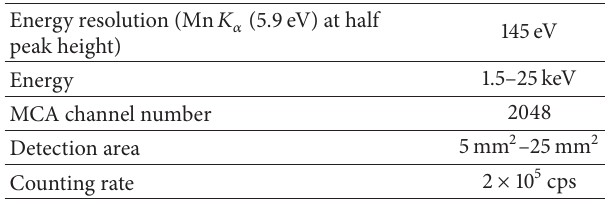
Table 1: X-123 key parameters.